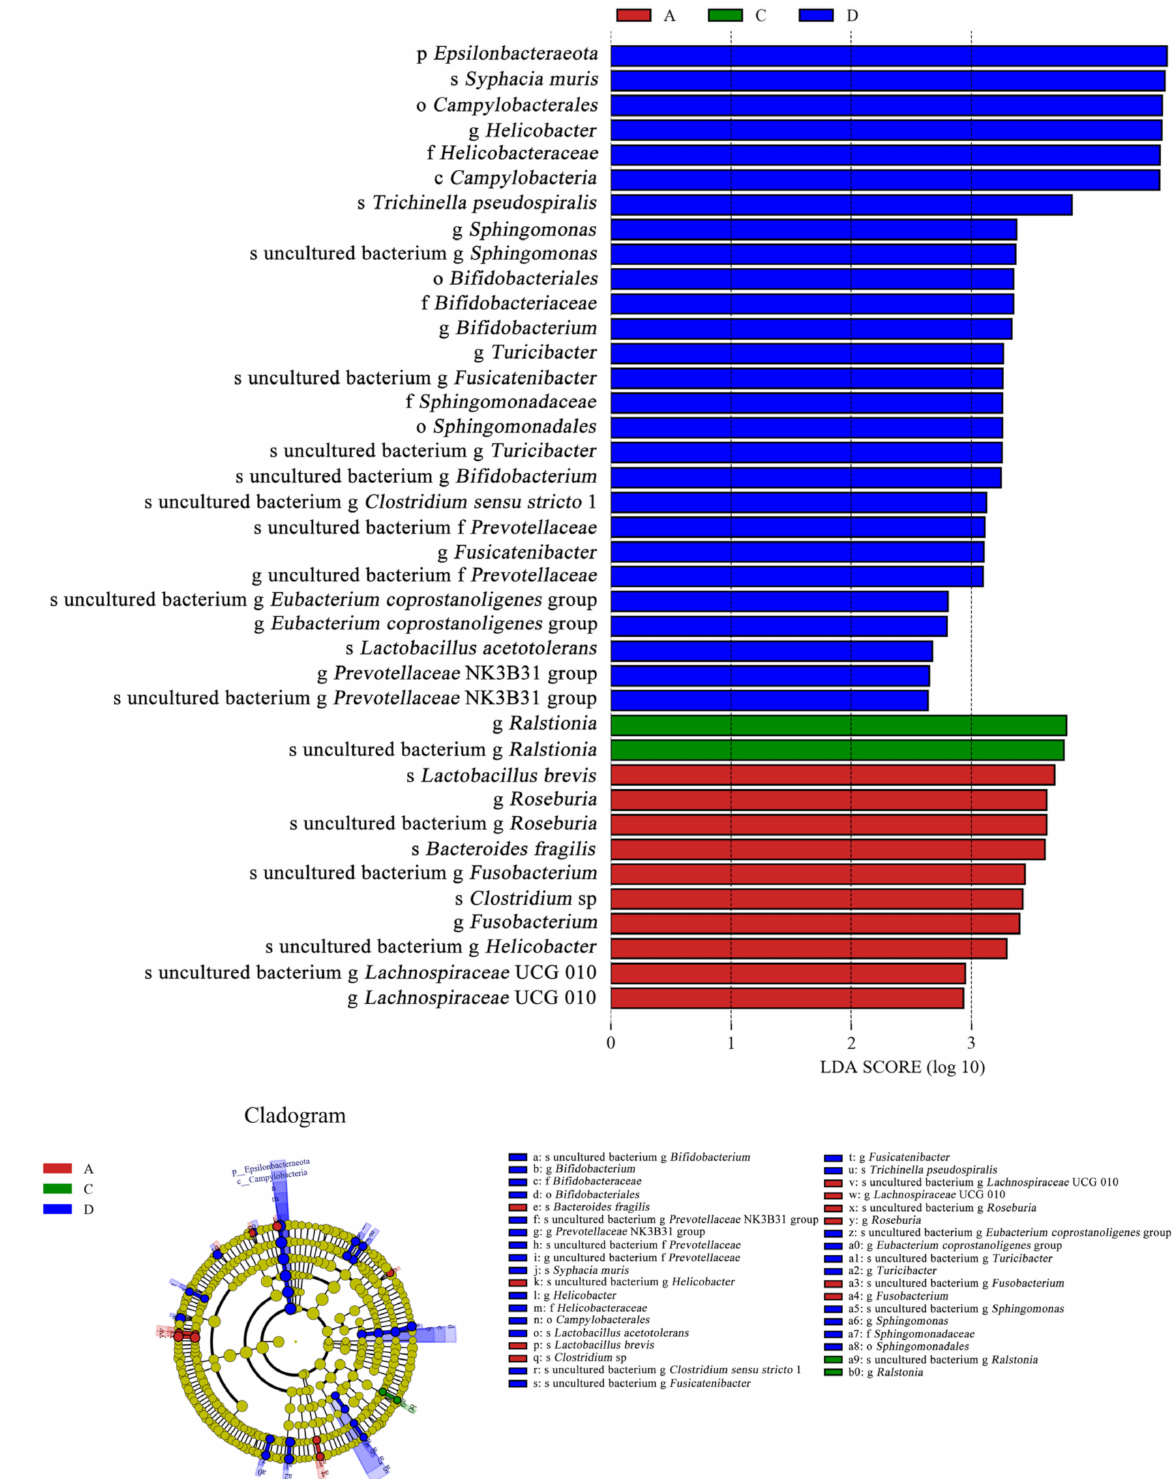
Figure 11. LEfSe analysis. Note: A: CON group, C: E. coli group, D: L.S + E. coli group. As shown in Figure 12A, ETEC K88 significantly decreased the abundance of Lach- nospiraceae , and as shown in Figure 12B, ETEC K88 significantly increased the abundance of Ralstonia . These results indicate that ETEC K88 reduced the abundance of beneficial bacteria and increased the abundance of harmful bacteria in the